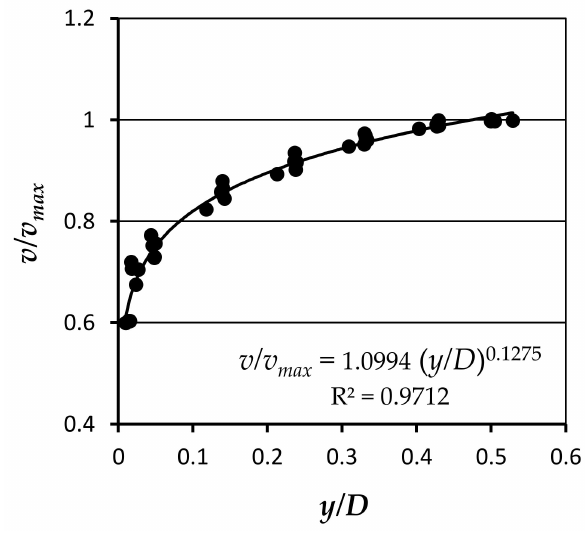
Figure 3. Velocity profile measured by Melisenda [5] for clear water.